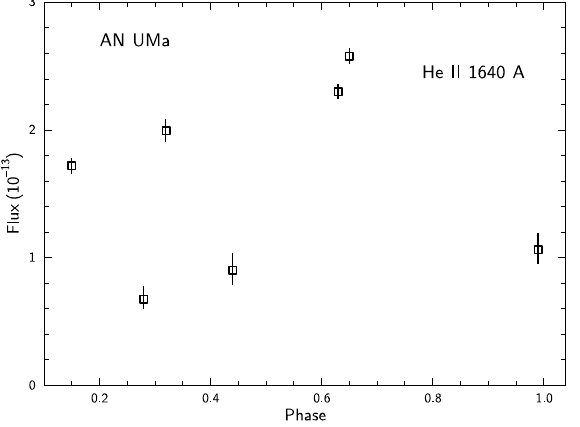
Fig. 12. The same as in Figure 11 but for the He II line. Table 6. Line (cid:13)uxes of HU Aqr from the HST spectra. The integrated (cid:13)uxes are in units of 10 (cid:0) 13 erg cm (cid:0) 2 s (cid:0) 1 . Data set